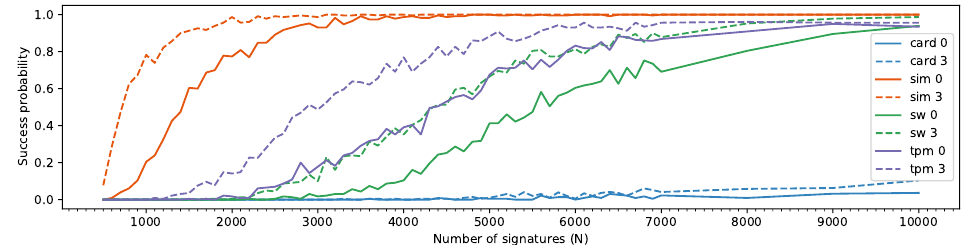
Figure 13: Success rate (averaged over the dimensions) of performing the attack using the Babai’s nearest plane algorithm, recentering and either with up to 3 errors fixed (3), or with no error fixed